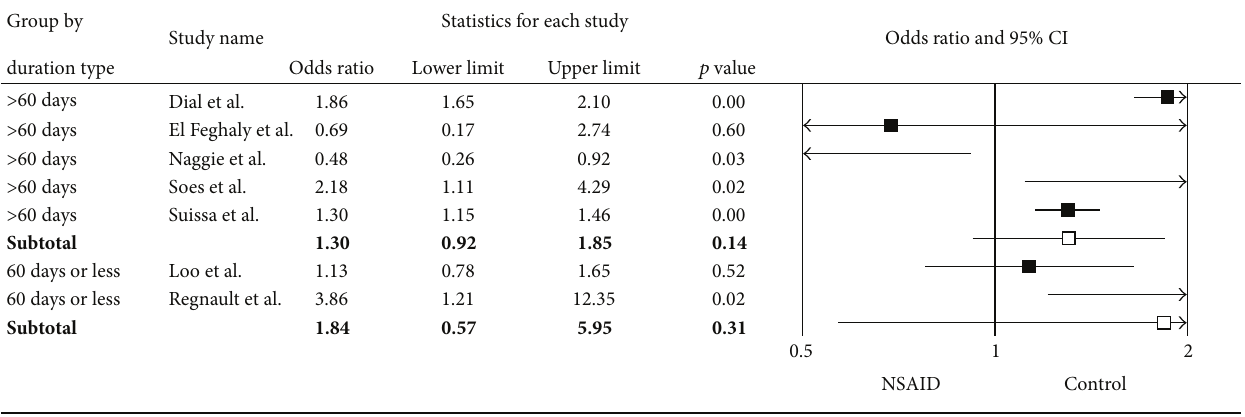
Figure 6: Forest plot of subgroup analysis by duration of NSAID